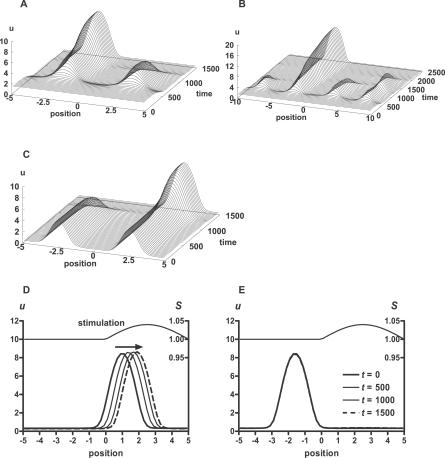
Numerical Evaluation of Uniqueness of Axis and Localization of Sensitivity in Model I(A–C) Numerical evaluation of uniqueness of axis. We set u = 1.65, v = 0.35, and S = 1. These values of (u, v) were derived from f(u, v) = 0 and u + v = 2. The system size was taken as L = 10 (A) or L = 20 (B). We gave random perturbation (±0.01), and the simulation was run for the indicated time (A,B). (C) Next, we obtained a stable single peak in Model I by setting L = 5 and taking the initial state as u = 1.65 and v = 0.35. Because we applied the periodic boundary condition to this system, we could set the center of the concentration peak at x = 0 by translation. By duplicating and coupling this profile (L = 5), we obtained a new profile (L = 10) with two peaks. We gave small perturbation (±0.01) to this profile (L = 10), and the simulation was run for the indicated time (C).(D,E) Numerical evaluation of localization of sensitivity. We obtained a stable single peak in Model I by setting L = 10 and S = 1, and taking the initial state as u = 1.65 and v = 0.35. We set the center of the concentration peak at x = 1.0 (D) or x = −1.6 (E) by translation. Then we gave a new stimulation S = 1 (x < 0) and S = 1{1 + 0.04cos[2π(x/L − 0.25)]} (x ≥ 0). The stimulation gradient is given only at the area of x > 0. The simulation was run for the indicated time (D,E).